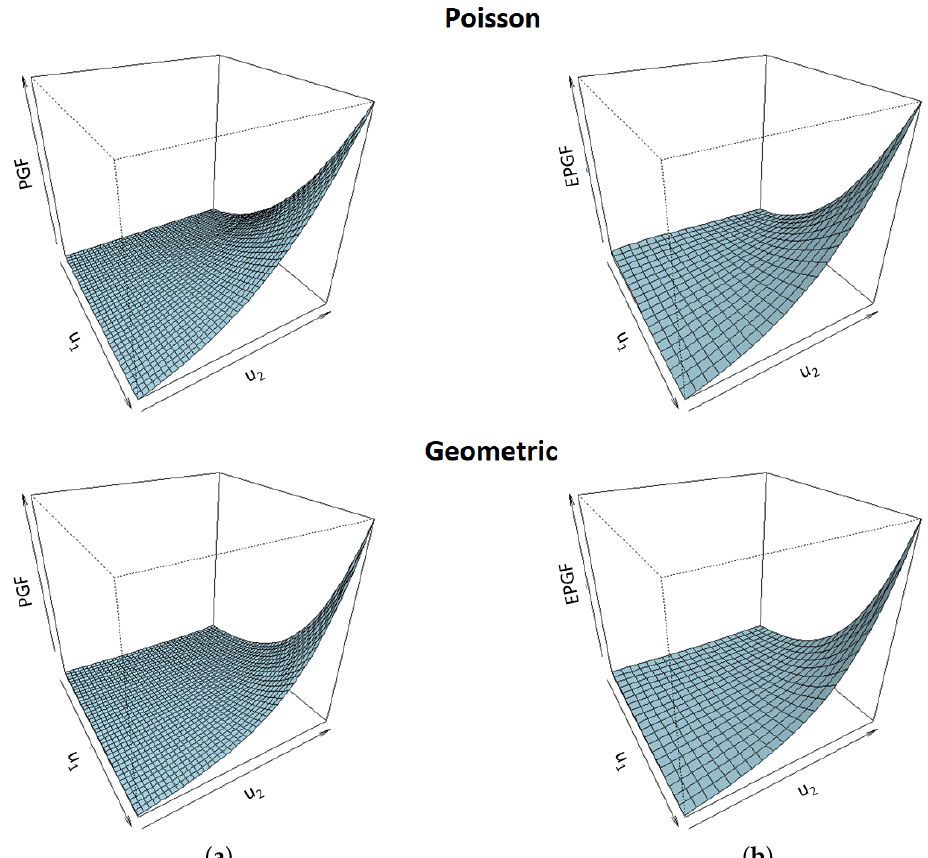
Figure 3. Three-dimensional plots of the two-dimensional PGFs ( a ) and empirical PGFs ( b ) of the INAR(1) series with Poisson innovations (panels above) and geometric innovations (panels below). True parameters’ values are θ = α =